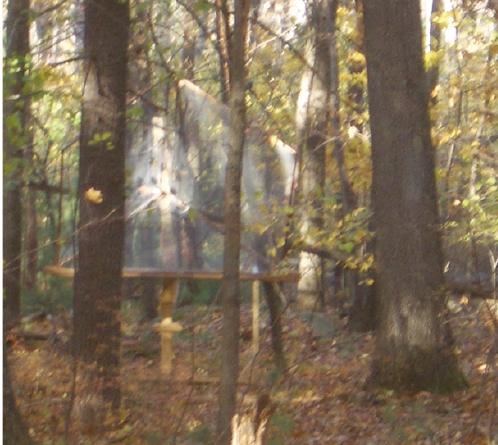
Figure 3: The target (a trihedral reflector) is shown on the stand at 300 feet from the